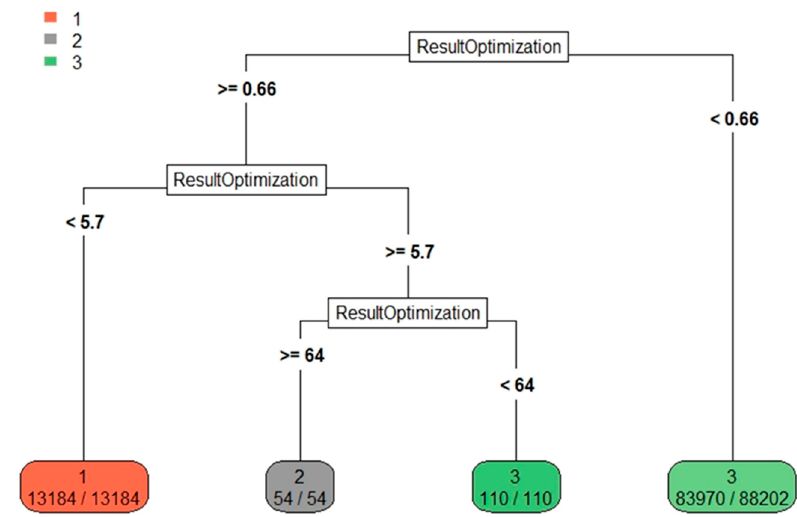
Figure 8. Decision tree. Results for the week days scenario.